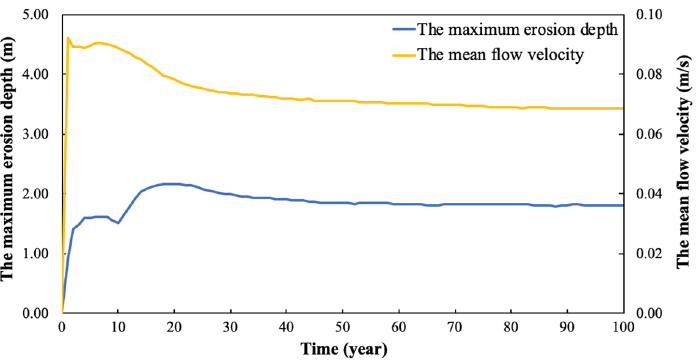
Figure 5. The maximum erosion depth and the mean flow velocity in the control group for the la- goon.